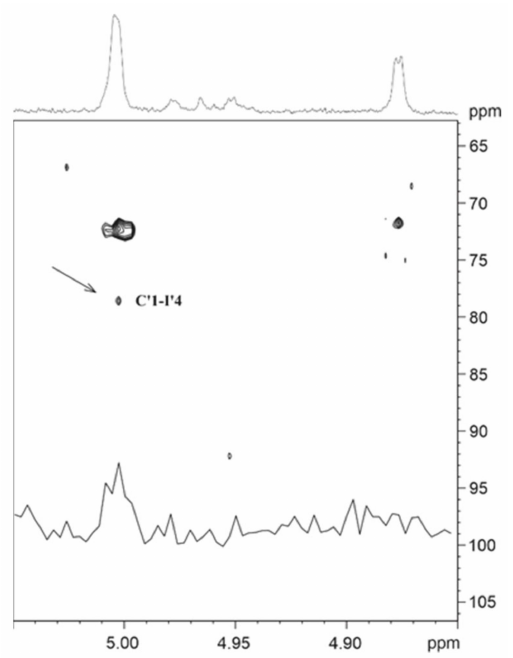
Figure 5. Region of the 2D-HMBC spectrum from the B. fragilis ∆ BF4306 glycopeptide f28. The arrow marks the inter-glycosidic cross-peak from the anomeric proton of Rha C’ to carbon 4 of the Man I’ . The inserted trace shows the 1 H row at the carbon frequency of the inter-glycosidic cross-peak C’ 1- I’